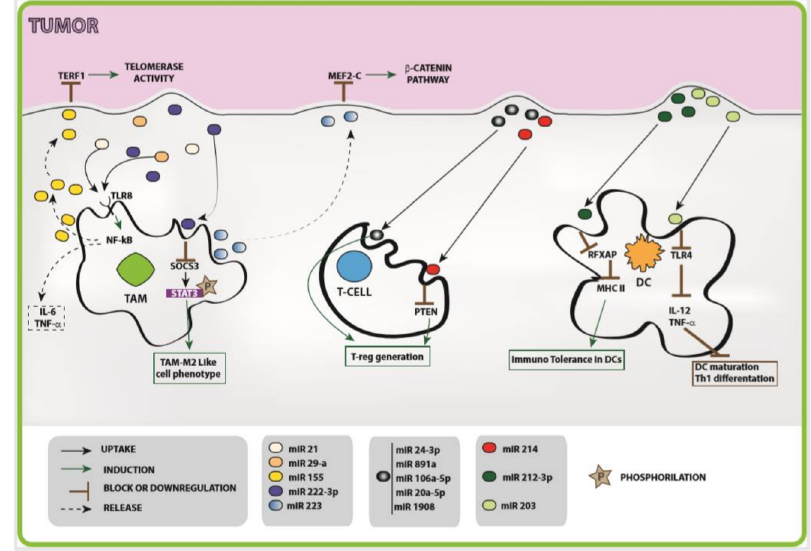
Figure 1. Schematic representation of TEX- and miRNA-mediated crosstalk between cancer cells and the immune